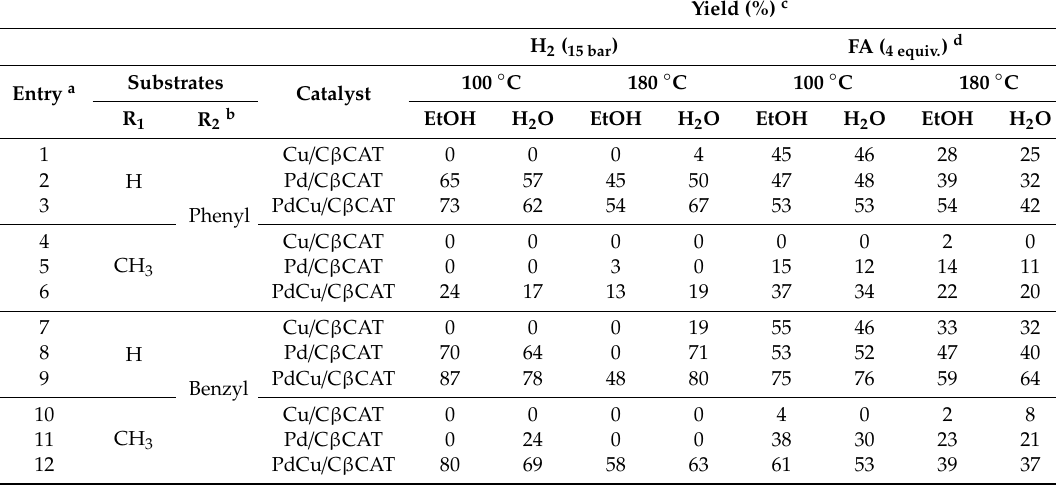
Table 1. MW-Assisted Reductive Amination (C β CAT